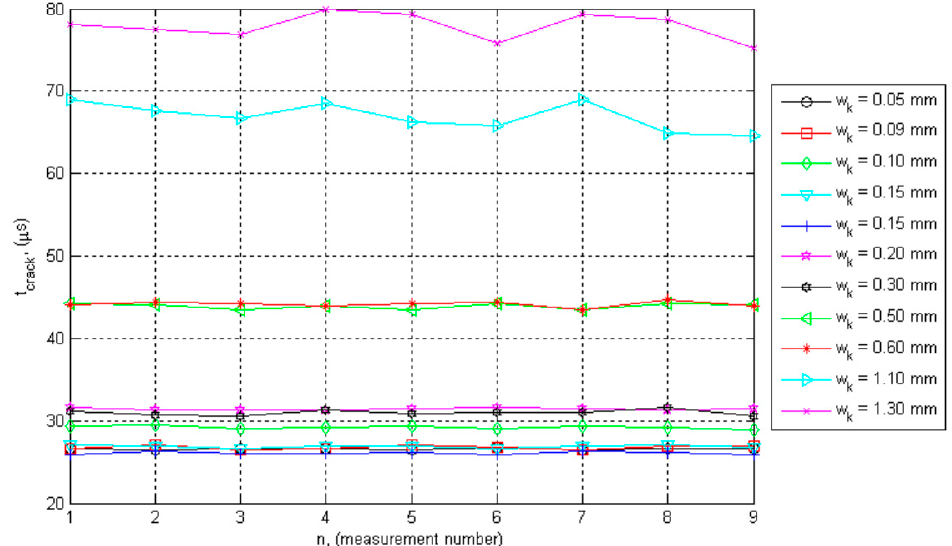
widths are given in Table 1.